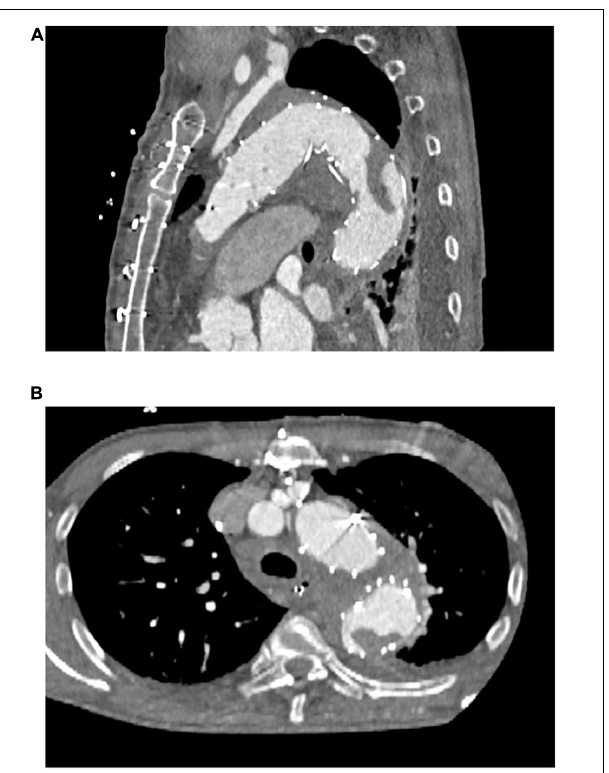
FIGURE 1 | Representative computed tomography angiographic images of a newly detected postoperative thrombus formation within the frozen elephant trunk stent-graft. (A) Sagittal plane (B) axial